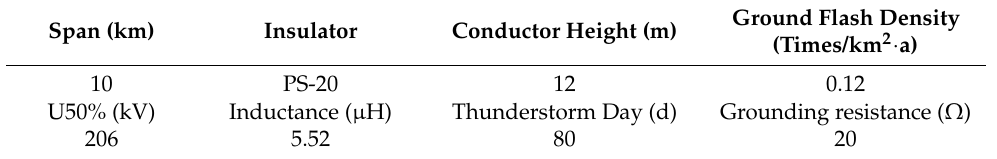
Table 1. Line parameters table.